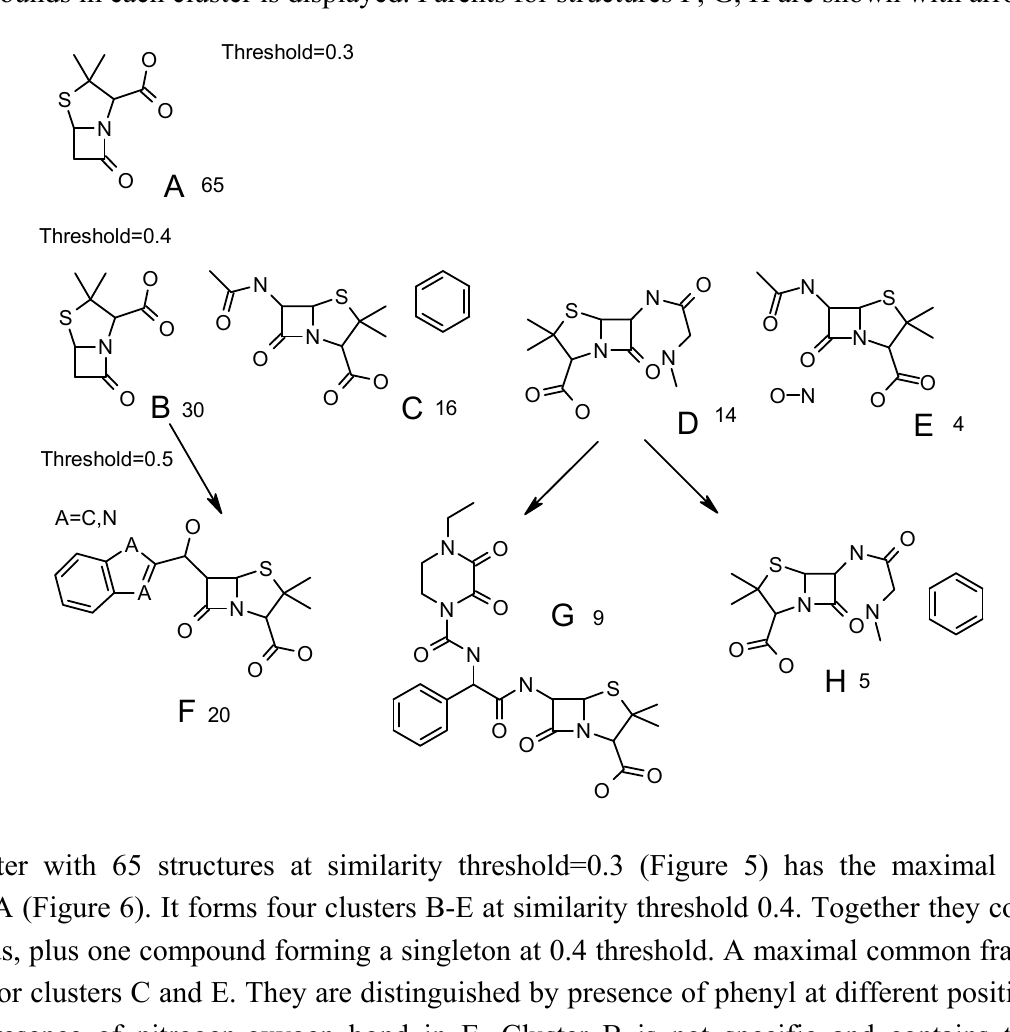
Figure 6. Common fragments, found for clusters at different similarity threshold. Number of compounds in each cluster is displayed. Parents for structures F, G, H are shown with